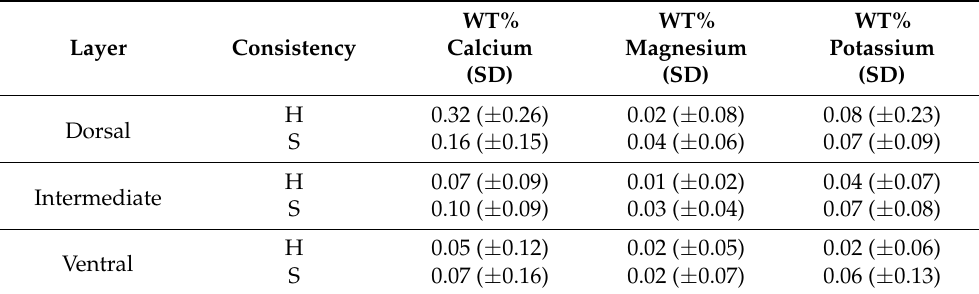
Table 6. WT% values for the three predictive variables of the model. WT%, weight percentage; SD, standard deviation; H, hard; S,